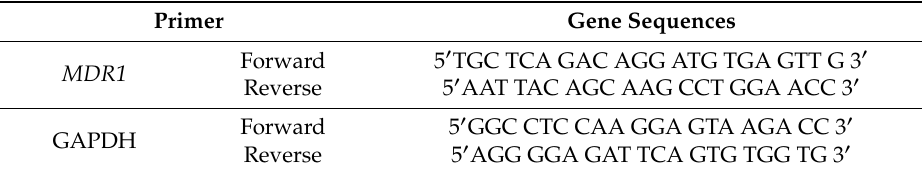
Table 2. Primer gene sequences for real-time